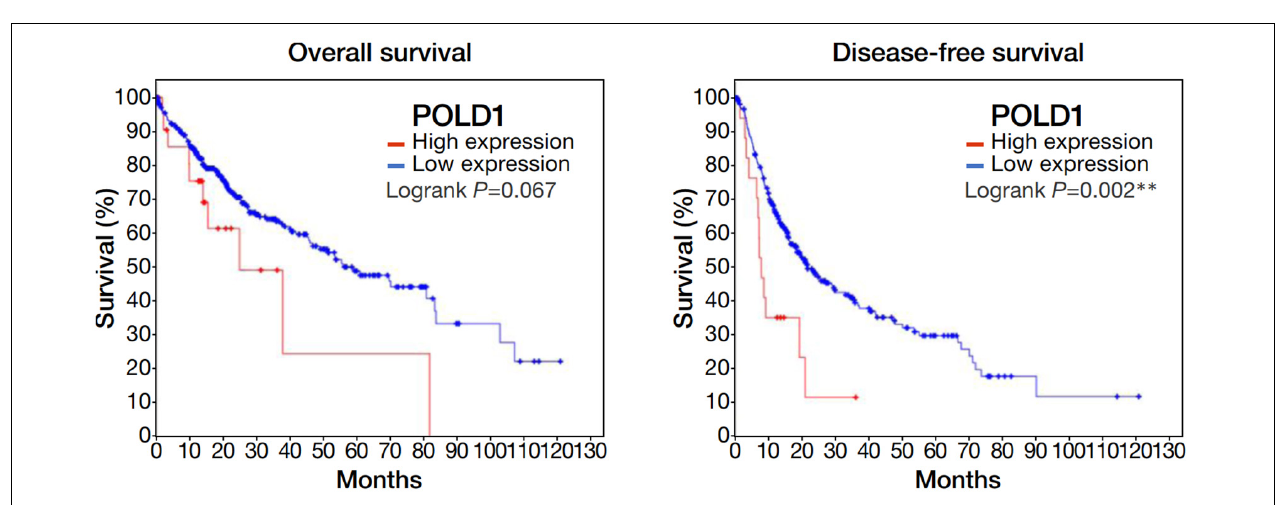
FIGURE 6 | Upregulation of POLD1 in HCC tumors was associated with poorer prognosis in TCGA dataset. Kaplan-Meier curves displayed the overall survival and disease free survival rates of HCC patients with higher POLD1 expression relative to those with lower expression. Higher POLD1 expression was based on a threshold of 2 for the mRNA expression z-scores relative to diploid